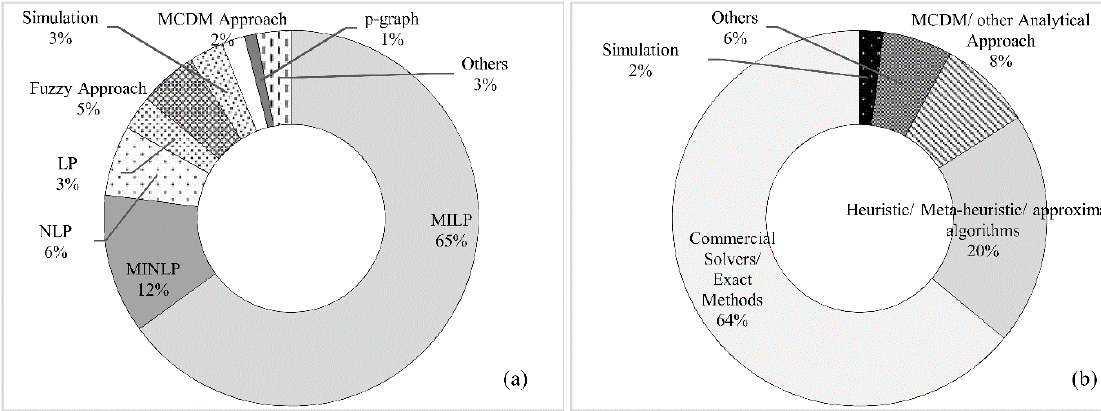
Figure 9. a) The portion of different employed modeling approaches; b) The portion of